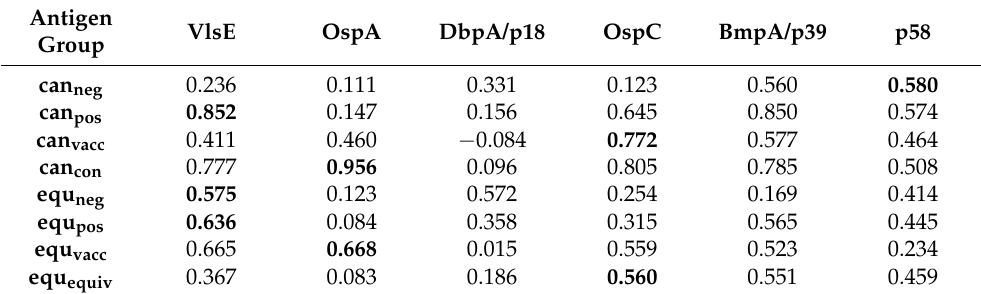
Table 7. κ 2 for comparable antigen-antibody-complex signals on LIA A and B when canine or equine sera were applied. The degrees of agreement are categorized into “none to slight” ( κ 2 < 0.2), “fair”